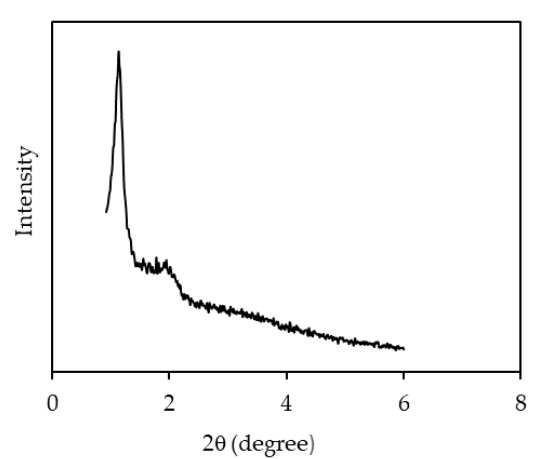
Polymers 2020 , 12 , x FOR PEER REVIEW